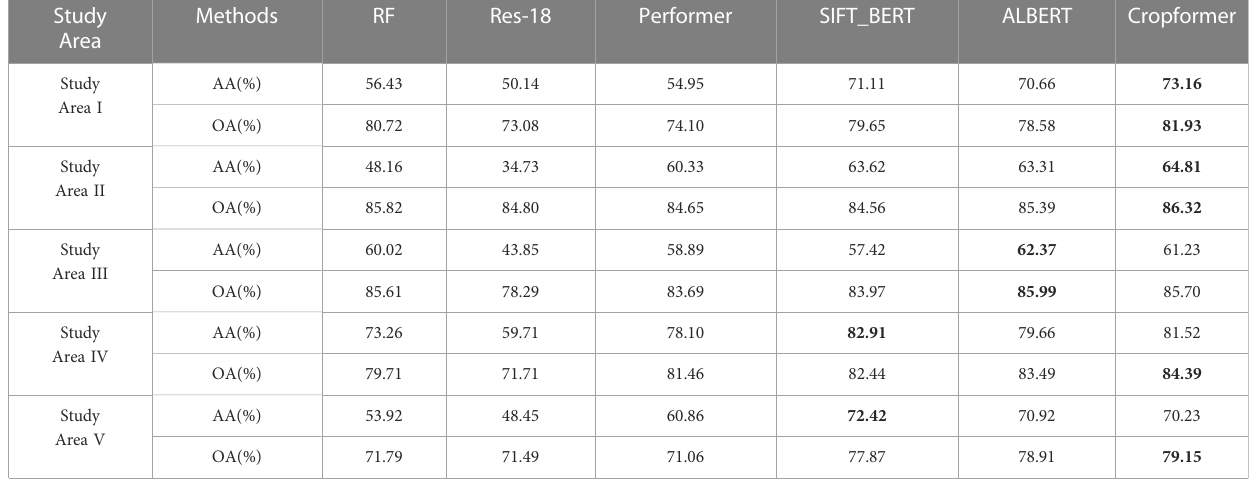
TABLE 3 Performance comparison of cropformer and other classi fi ers in three study